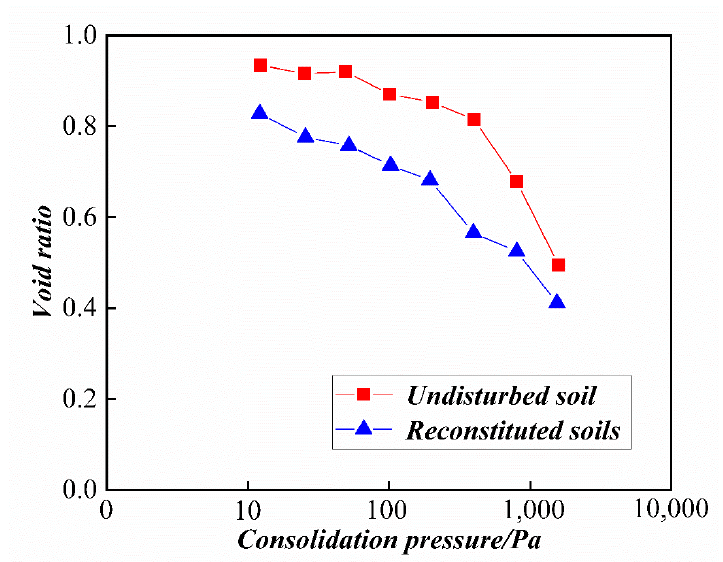
Figure 3. High-pressure consolidation curves.